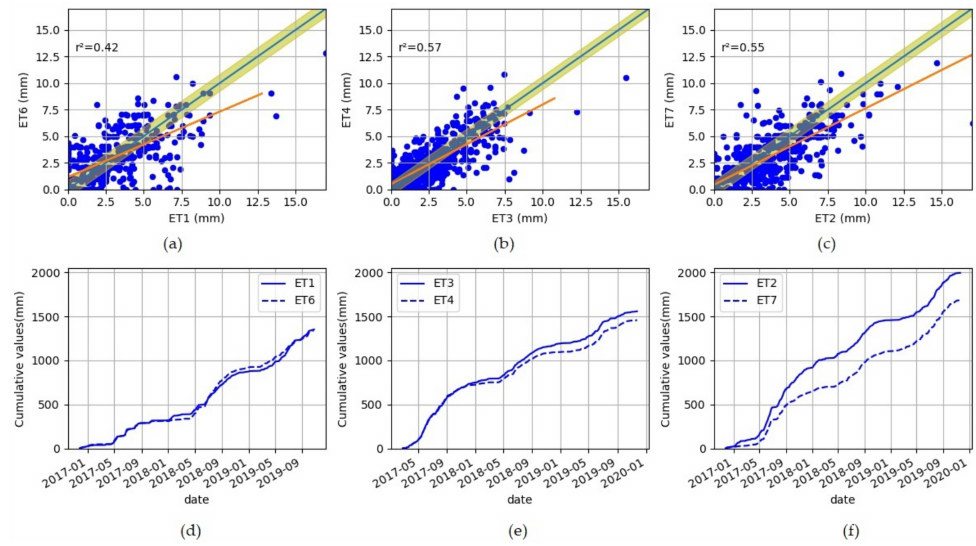
Figure 6. Regressions ( a – c ) and cumulatives ( d – f ) plots comparing the three replicas ET1/ET6 (data = 445), ET3/ET4 (data = 600) and ET2/ET7 (data = 583) for the three years (1096 days). The red line refers to the regression line and the blue line represents the y = x surrounded by the confidence interval (at 95%) that corresponds to the square root of the sums of the squares of the lysimeter uncertainties for each replica (0.79 mm, 0.63 mm, and 0.71 mm, respectively for ET1/ET6, ET3/ET3, and ET2/ET7).